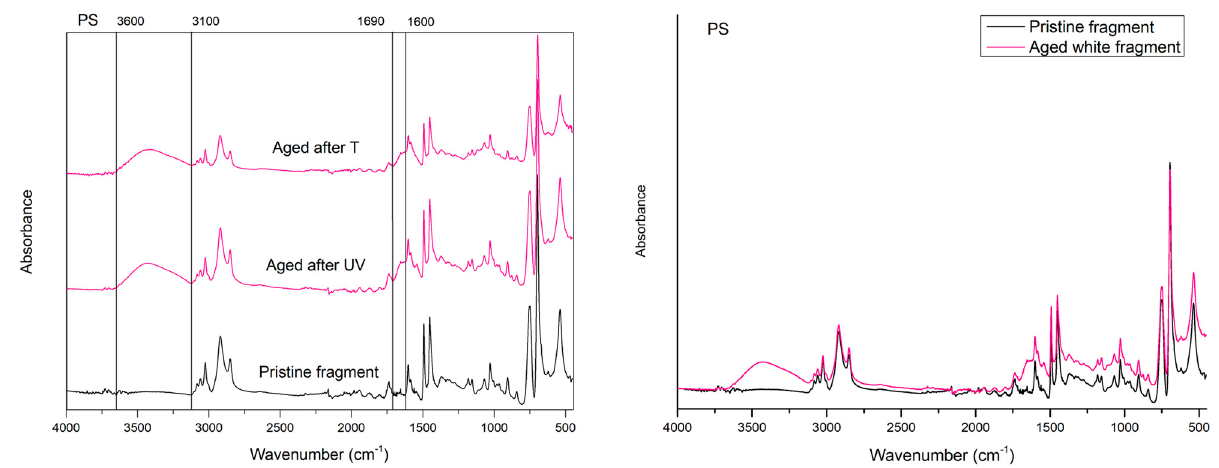
Figure 3. Comparison between the spectrum of the PS pristine fragment (black line) and aged white fragment (red line), after 20 days of photo-oxidation and 25 of thermos ageing in controlled conditions.